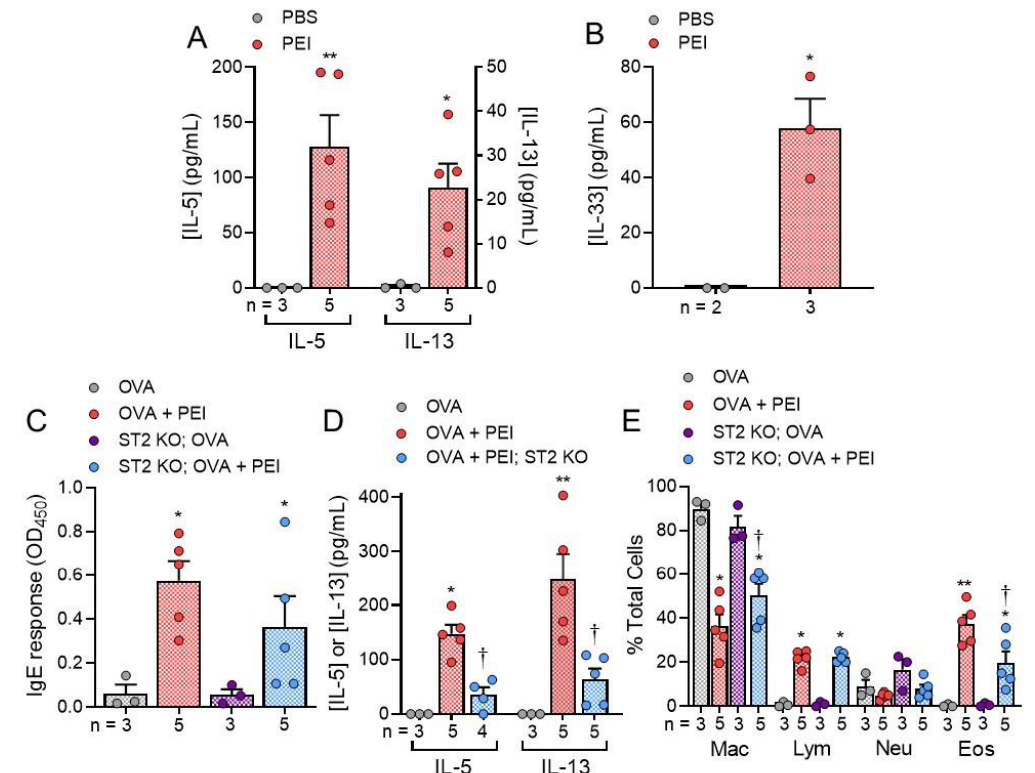
Figure 6. In vivo experiments showing an increase in type 2 immune responses following exposure to PEI alone or PEI-OVA polyplexes. ( A ). Intranasal PEI stimulates IL5 and IL-13 secretion into BAL fluid (* p = 0.0260; ** p < 0.0113). ( B ). PEI (12.5 μ g/mL) also increased IL-33 concentration in BAL samples (* p = 0.0324). ( C ). Effects of OVA and OVA + PEI on the level of IgE in plasma (* p < 0.03). ( D ). Intranasal administration of PEI + OVA increases IL-5 and IL-13 secretion, which was blocked in ST2 deficient mice (* p = 0.0017; ** p = 0.0078). ( E ). BAL immune cell counts following stimulation with 5 μ g/mL PEI exhibited increased numbers of lymphocytes and eosinophils but not neutrophils (Mac: * p < 0.0001 compared to OVA alone; † p = 0.0073 compared to ST2 KO; OVA; Lym: * p < 0.0001 compared to OVA alove or ST2 KO; OVA). The increase (** p = 0.0003 comparing OVA alone to OVA + PEI and * p = 0.0424 comparing ST2 KO; OVA to ST2 KO; OVA + PEI) in eosinophils was reduced in ST2 deficient mice (Eos: † p < 0.0290 comparing OVA + PEI to ST2 KO; OVA + PEI). Unpaired t tests were used in A and, B, and a one- way ANOVA followed by Tukey’s multiple comparison’s posttest was used in C – E.